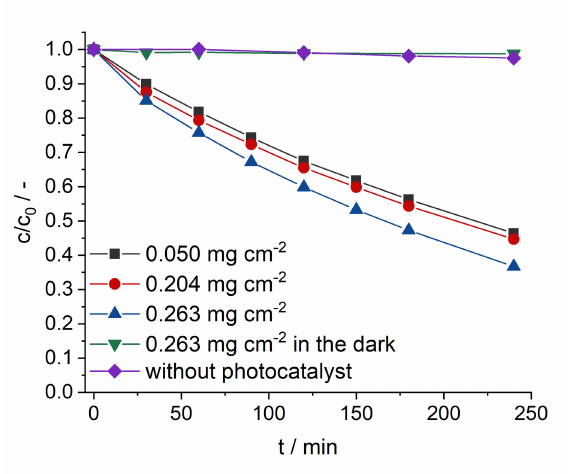
Figure 5. Acid Orange 7 concentration (measured by UV–vis spectroscopy) decrease under light (without photocatalyst and for 3 contents of g-C 3 N 4 ) and in the dark. A one-week-aged suspension was used for layer deposition on FTO glass, and the light source was UV Sylvania Lynx-S BLB, with a broad maximum at 365 nm. The initial concentration of AO7 was 10 − 4 mol dm − 3 .